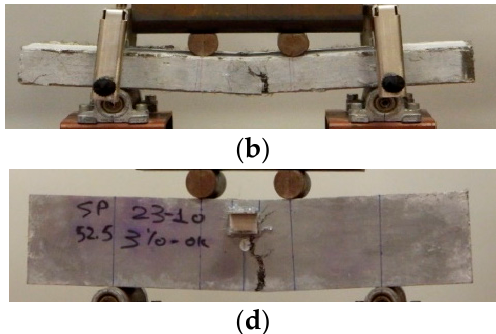
Figure 4. Characteristic failures of selected typical prisms for ( a ) 25 mm, ( b ) 50 mm, ( c ) 75 mm and ( d ) 100 mm depths.